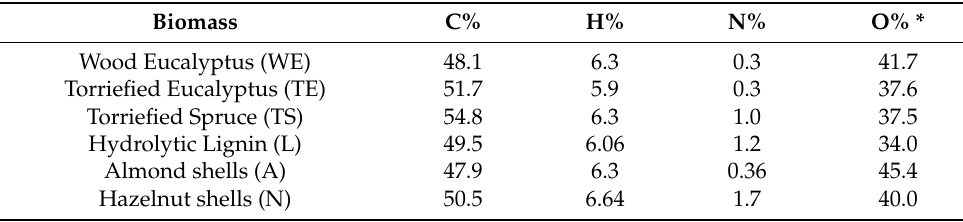
Table 1. Elemental composition of the feedstocks (% mass) [19,21,22].